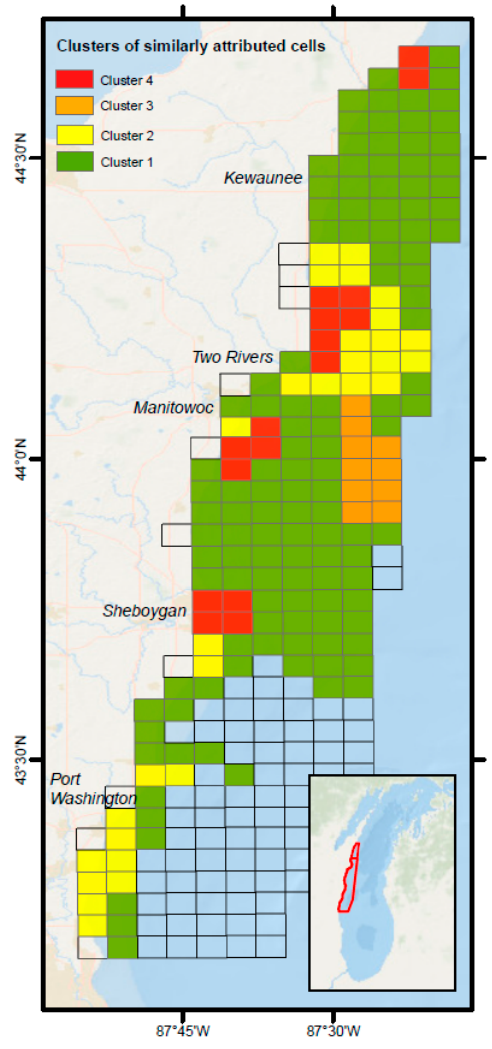
Figure 3. Cluster membership of the cells based on Justification and Map Products that were selected. Note that, in this and other figures like it, the cells appear rectangular due to the map projection. Inset shows the position of the proposed sanctuary in Lake Michigan.